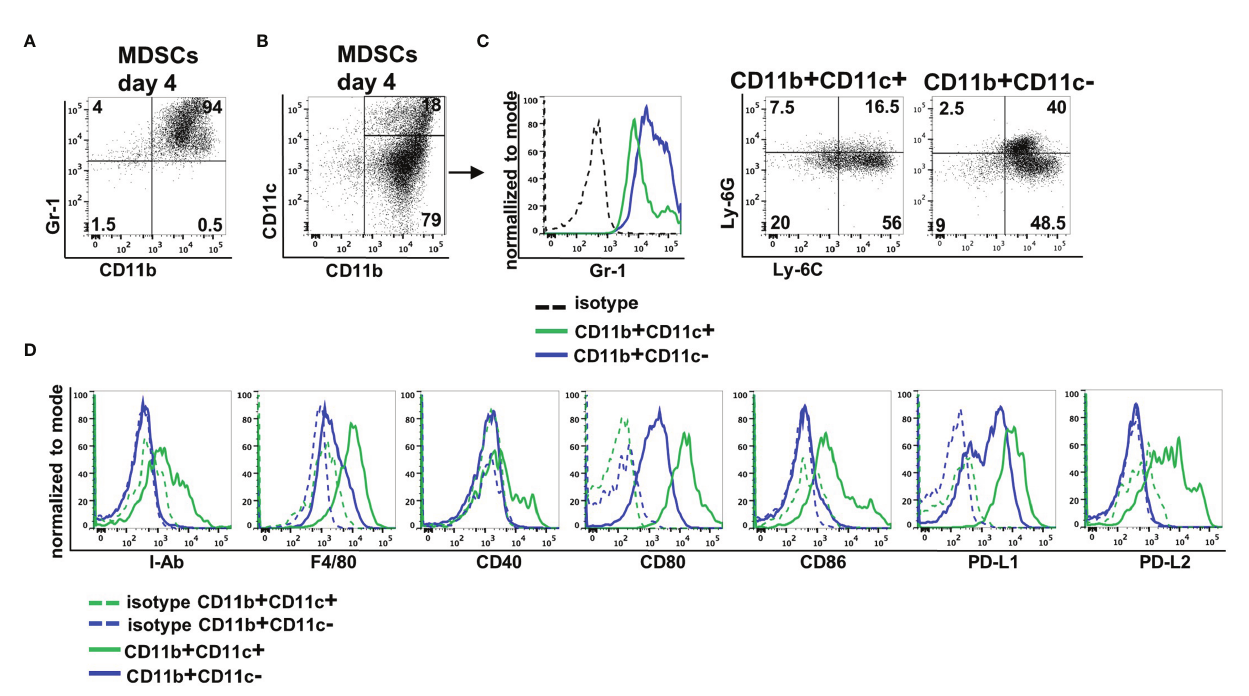
FIGURE 1 | In vitro -generated MDSCs consist of CD11b+CD11c+ and CD11b+CD11c − MDSCs. MDSCs were generated from BM cells in the presence of GM- CSF. (A) After 4 days, MDSCs were stained for CD11b and Gr-1 expression or (B) for CD11b and CD11c expression. (C) Expression of Gr-1 was determined on